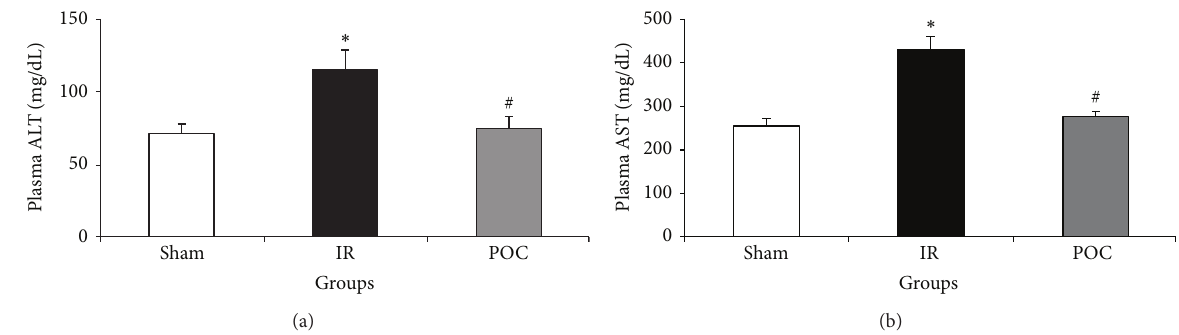
Figure 1: Changes in serum ALT (a) and AST (b) in different groups. The data are presented as mean ± SEM. ∗ 𝑃 < 0.05 versus sham group. # 𝑃 < 0.05 versus IR group. IR: 45 min renal ischemia followed by 24 hours of reperfusion. POC group: 4 cycles of 10 seconds of intermittent IR just at the beginning of reperfusion in the